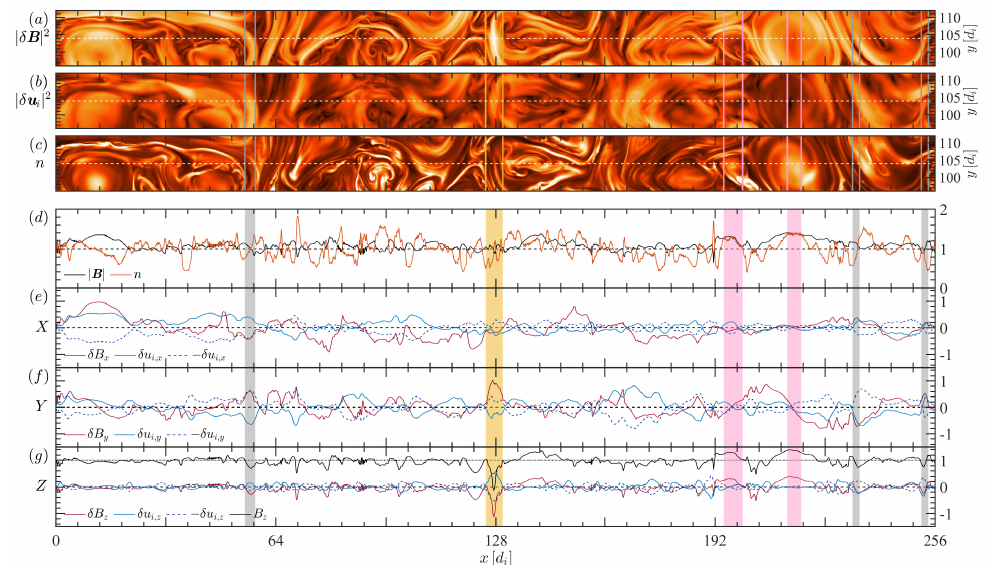
Figure 2. Horizontal 1D cut of the simulation domain for Run 1 at y = 104 d i . The three top panels show a 2D rectangular area of height 16 d i around the 1D cut for different fields: the magnitude of the magnetic fluctuations, | δ B | 2 (panel a ), the magnitude of the ion bulk velocity fluctuations, | δ u i | 2 ( b ), and the density, n ( c ). The bottom four panels show the 1D cut for different scalar quantities, i.e., the magnitude of the magnetic field and the density ( d ), and the three components of the magnetic field and the ion bulk velocity ( e – g ). We compare each component δ B ˆ  with both δ u i ,ˆ  and − δ u i ,ˆ  (with ˆ  = x , y , z ) to better identify regions where the fluctuations are